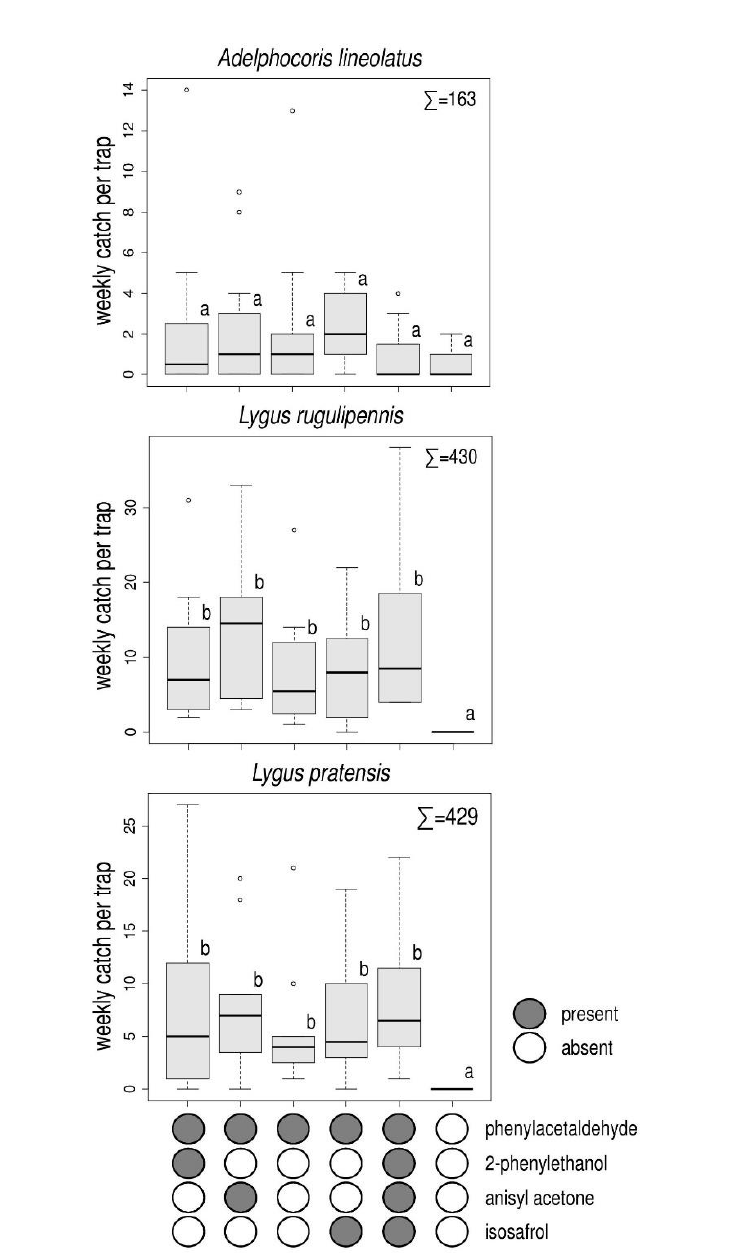
Figure 2. Weekly catches of Adelphocoris lineolatus , Lygus rugulipennis and L. pratensis in phenylacetaldehyde baited traps alone, in combination with either isosafrole, anisylacetone or 2-phenylethanol, in combination with their ternary blend and in unbaited traps (Experiment 2). (Significance: Kruskal-Wallis test, pairwise comparisons by Wilcoxon test with Bonferroni correction at p=0.05). ’∑’ indicates the total number of individuals caught of the respective species in the experiment. Table 1. Mean catch of Adelphocoris lineolatus , Lygus rugulipennis and Lygus pratensis in semiochemical baited traps (catch/trap) and sweep-net samples (catch/100 sweeps) and ratio of females in 2016 in Fürjes (Hungary), for composition of blends, please refer to the text. Baits and